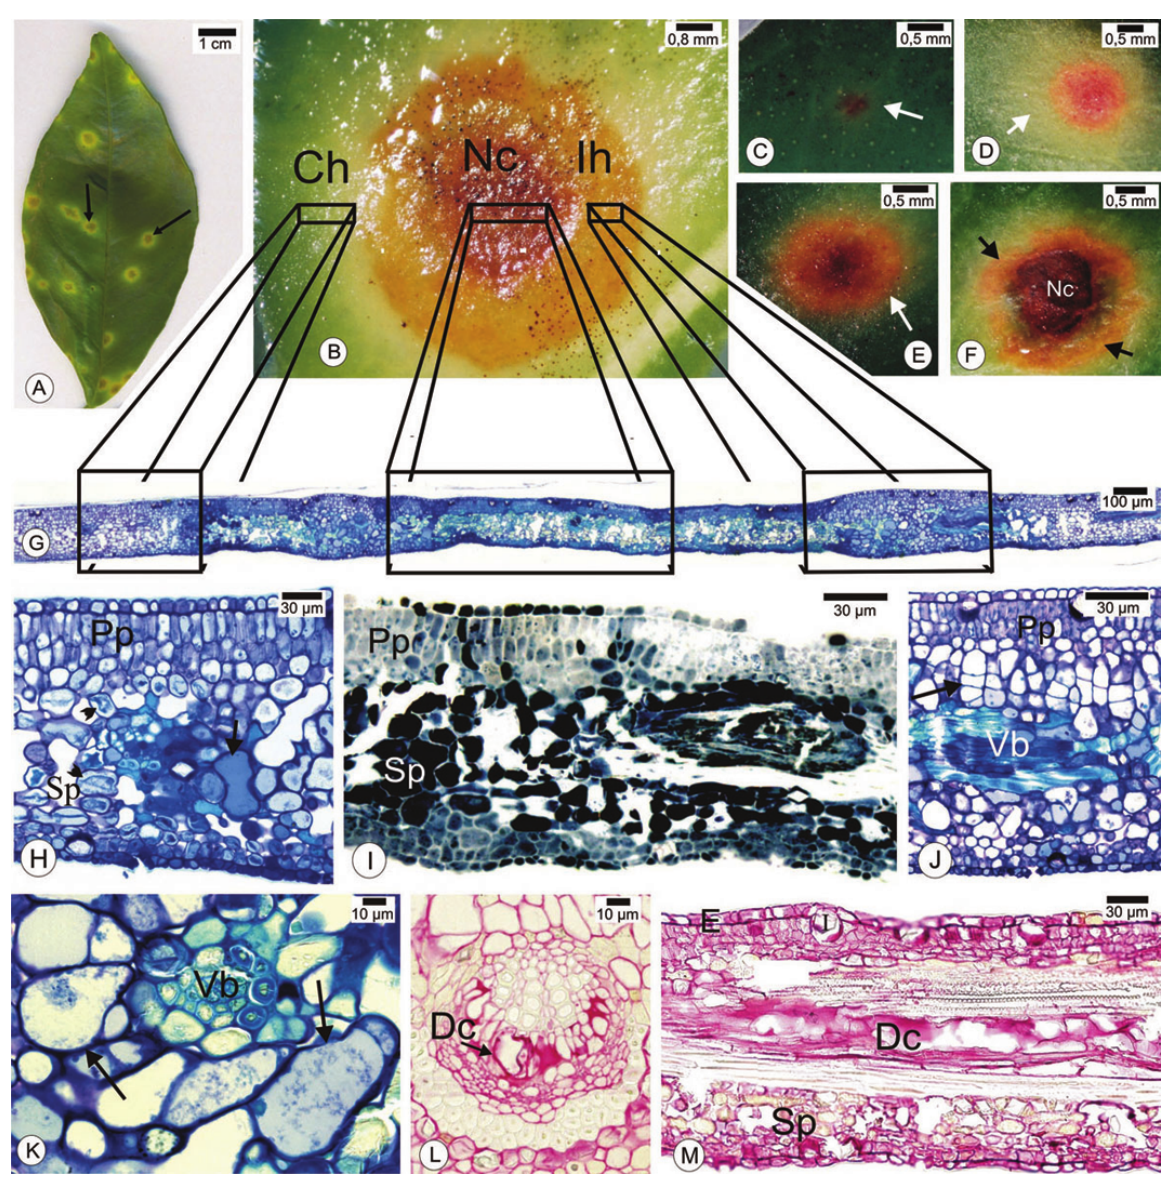
Fig. 1 – Leaf lesions caused by CiLV-N in Citrus sinensis (L.) Osbeck ‘Pêra’. Sections stained with Toluidine Blue (G,H,J,K); Sudan Black B (I) and Ruthenium Red (L,M). A. Overview of injured leaf. B. Typical lesion showing all three regions. C-F. Stages of lesion formation. The arrows indicate the rise of the intermediate halo. G. Cross section of the lesion with each rectangle corresponding to the region indicated in B. H. Chlorotic halo region. Notice the plasmolysis in the spongy parenchyma (arrowheads) and hipertrofied cell (arrows). I. Necrotic center of the lesion. J-K. Intermediate halo region. J. Hyperplasia (arrow) of cells above the vascular bundle. K Hypertrophy (arrows) in vascular bundle sheath cells. L-M. Detail of intermediate halo shows in the vascular bundles in cross (L) and longitudinal (M) sections of traumatic gum ducts (Dc). Ch – Chlorotic halo; E - Epidermis; Ih – Intermediate halo; Nc – Necrotic center Pp – Palisade parenchyma; Sp – Spongy parenchyma; Vb – Vascular